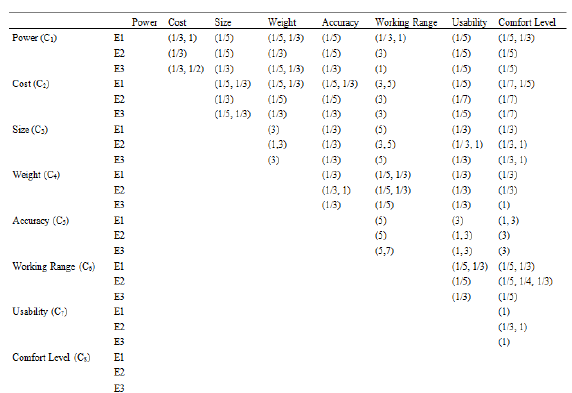
Table 2. Linguistic terms Table 3. Pairwise comparisons for importance degrees of the